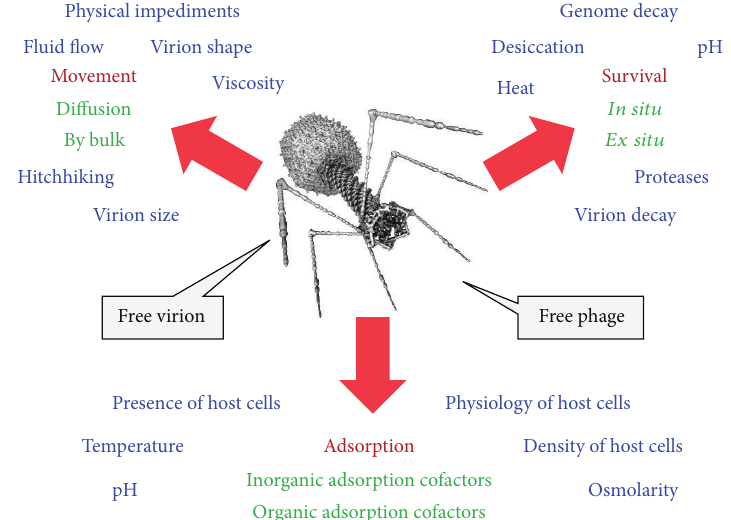
Figure 7: Phenomena impacting virions include their movement, their survival, and their adsorption. Shown also are various aspects of environments as relating to virion properties and functions (green text with subcategories in blue). The terms “free virion” and “free phage” are being used interchangeably in the